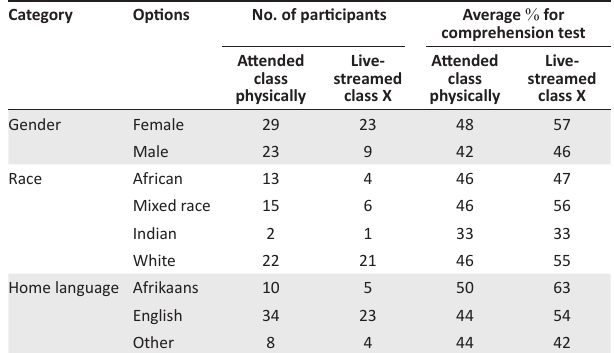
TABLE 3: Results of comprehension test per participant demographic and between the two locations.